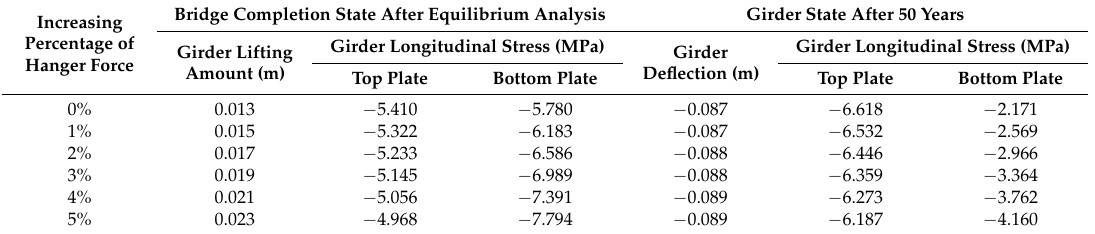
Table 6. Parametric study on the influence of final girder geometry in the girder state evolution. Increasing Percentage